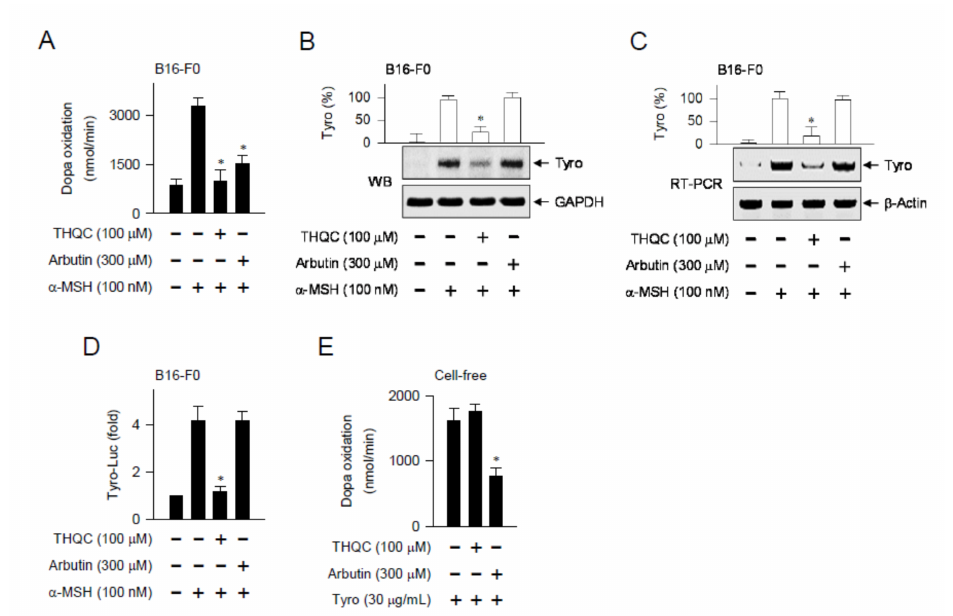
Figure 3. E ff ect of THQC on Tyro expression. B16-F0 cells were stimulated with α -MSH for 48 h ( A , B ) or 20 h ( C ) in the presence of THQC. ( A ) Cell extract as the enzyme source of Tyro was reacted with l -dopa as a substrate in sodium phosphate bu ff er, and immediately measured the increase in absorbance value at 475 nm per min. Tyro activity is represented as the initial velocity of dopa oxidation (nmol / min). ( B ) Protein extract was resolved on SDS acrylamide gel by electrophoresis and subjected to Western blot analysis (WB) with anti-Tyro or anti-GAPDH antibody. ( C ) Total RNA was subjected to semi-quantitative RT-PCR analysis of Tyro with the internal control β -actin and resolved on agarose gene by electrophoresis. ( D ) B16-F0 cells harboring the Tyro ( − 2236 /+ 59)-Luc reporter in combination with the Renilla control vector were stimulated with α -MSH for 18 h in the presence of THQC. Firefly luciferase activity, reporting the promoter activity of Tyro gene, was normalized to the Renilla activity and is represented as relative fold. ( E ) Tyro protein was treated with THQC and reacted with l –dopa as a substrate in cell-free reactions. Tyro activity is represented as the initial velocity of dopa oxidation (nmol / min). * p < 0.05 vs. α -MSH alone ( A – D ) or Tyro protein alone ( E ).